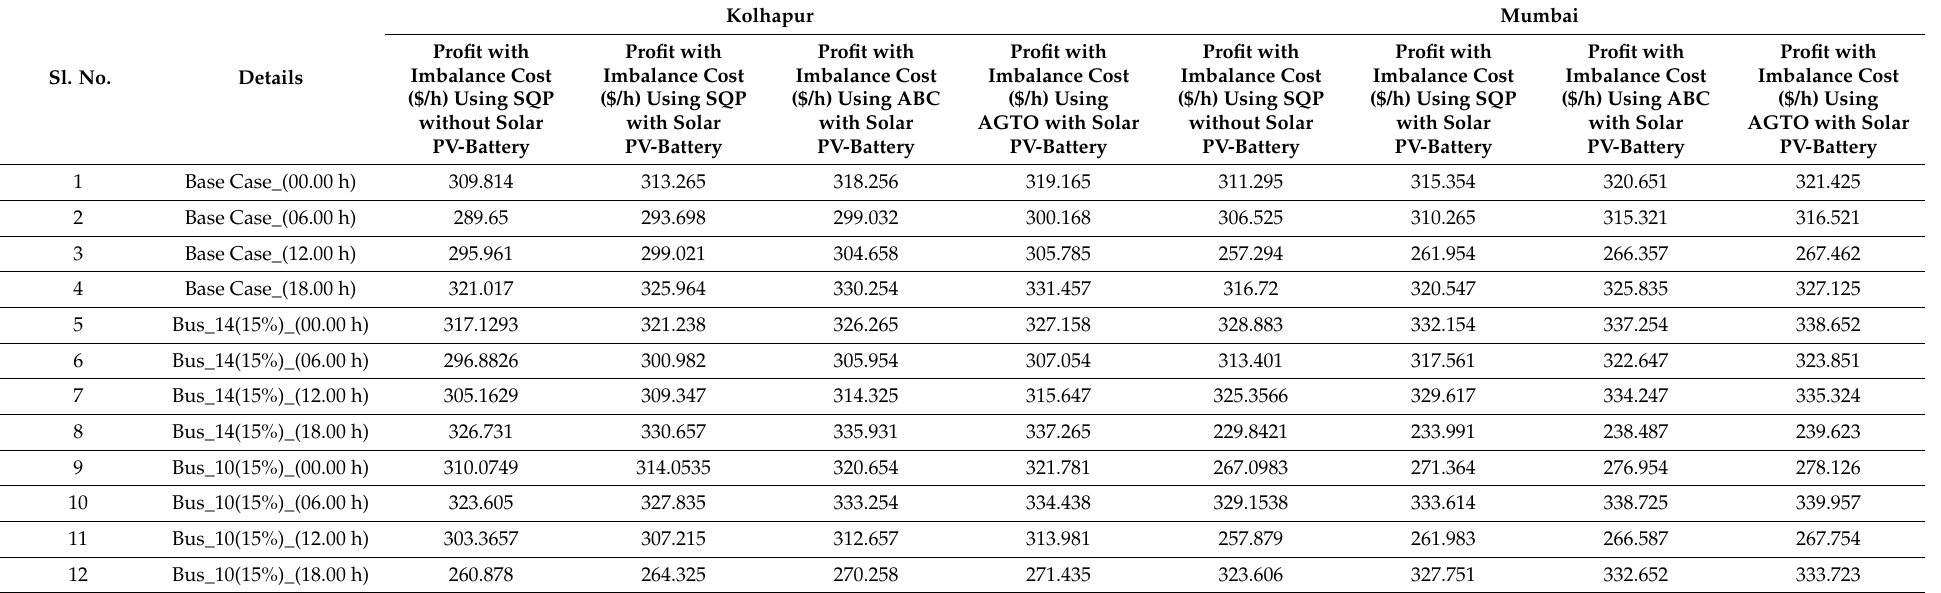
Table 7. System profit with different optimization techniques.